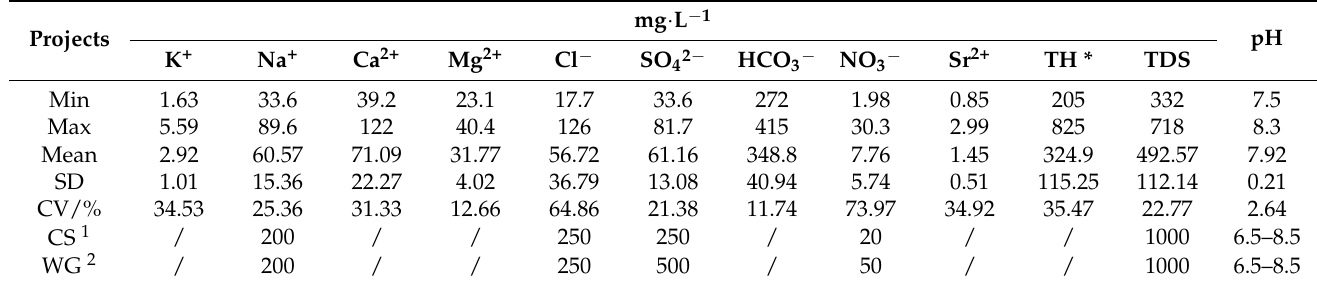
Table 1. Statistics on the hydrochemical characteristics of Sr-rich